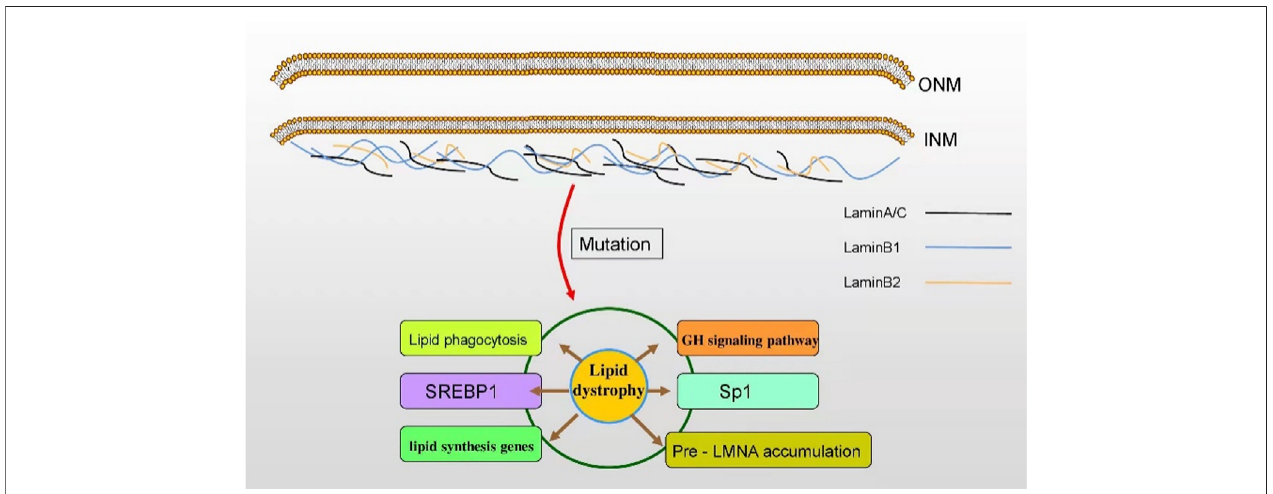
FIGURE 1 | The subtypes and roles of lamin. Lamin A/C, lamin B1, and lamin B2 are the fi brin network structures located at the lower layer of the inner nuclear membrane. Lamin is responsible for maintaining the nuclear shape, participating in signal transduction, organizing chromatin, repairing DNA, and inducing apoptosis. The mutation of LMN genes affect lipid dystrophy in various human diseases. INM: inner nuclear membrane; ONM: outer nuclear membrane.